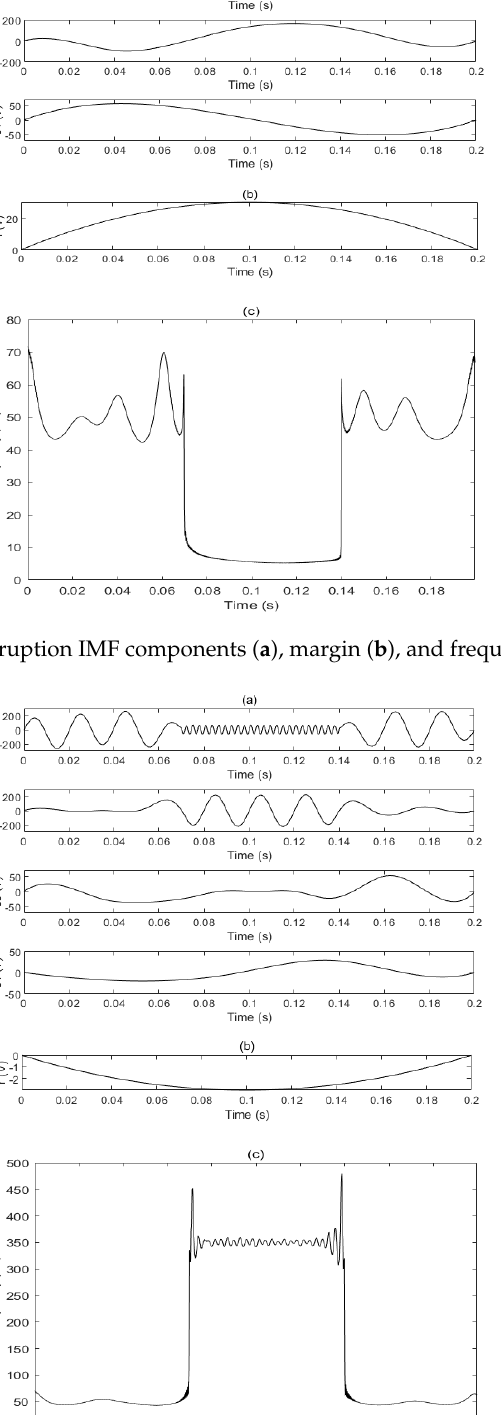
Figure 6. Oscillatory transient IMF components ( a ), margin ( b ), and frequency parameter ( c ).